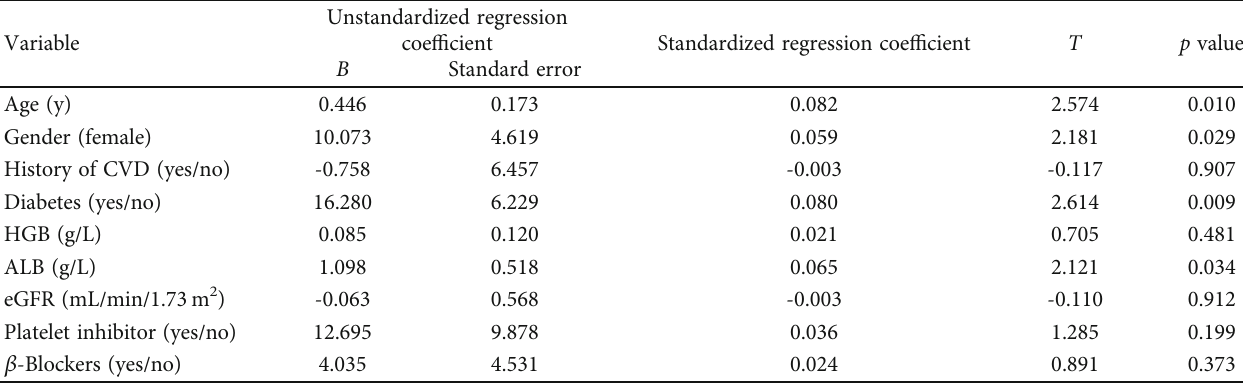
Table 2: Multiple linear regression analysis on in fl uencing factors of PLR.